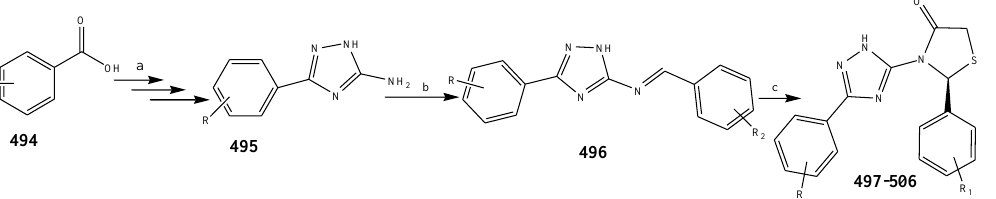
Scheme 40. Synthesis of thiazolidinone from benzylalcohol.